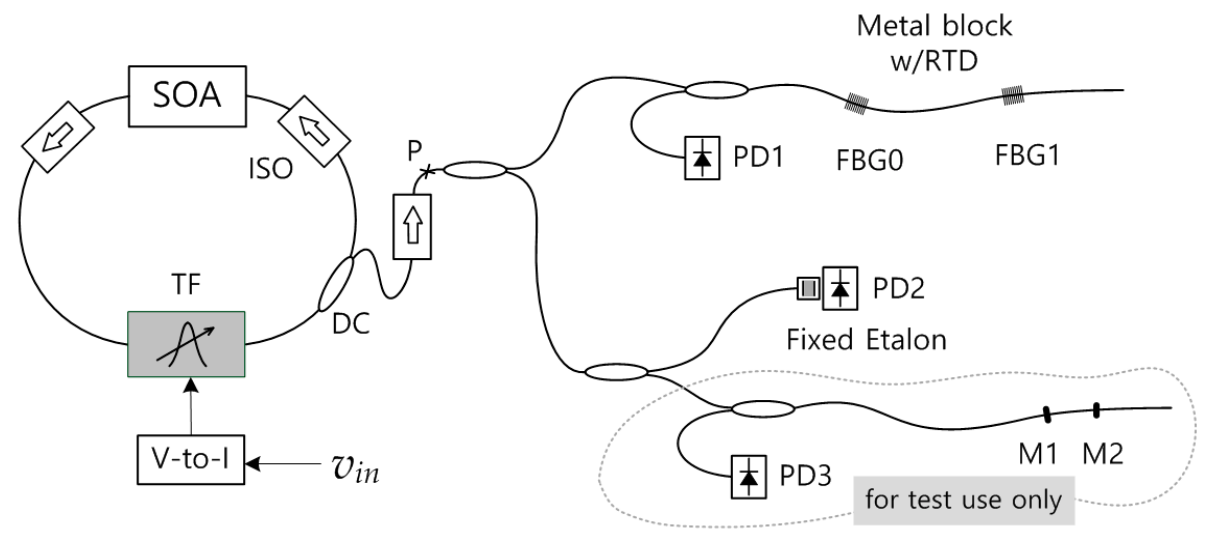
Figure 2. Optical setup: V-to-I, voltage to current converter; ISO, optical isolator (dual stage); PD, photodiode; DC, directional coupler; FBG, fiber Bragg grating; PD2, a custom-built fiber-pigtailed PD-etalon assembly; M1 and M2, mirrors inside the optical fiber.